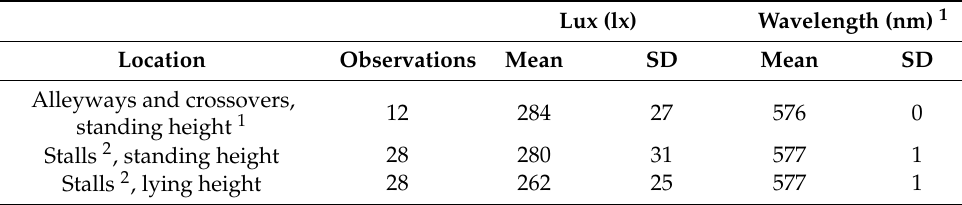
Table 1. Facility light (fluorescent lighting) distribution in the experimental pen.